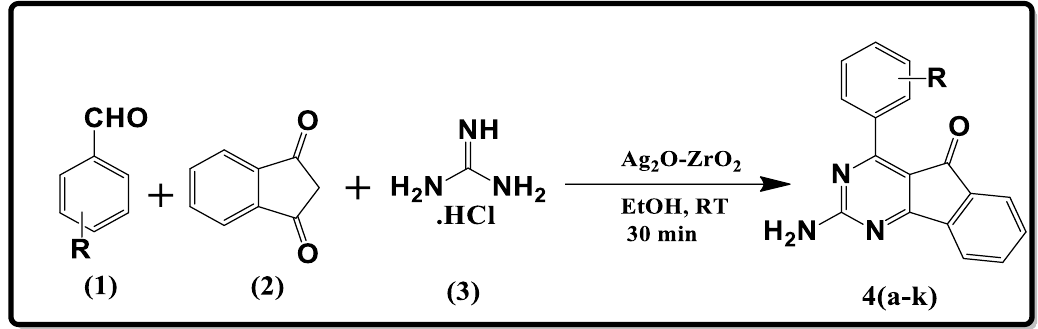
Scheme 1. Synthesis of novel indenopyrimidine derivatives. RT = room